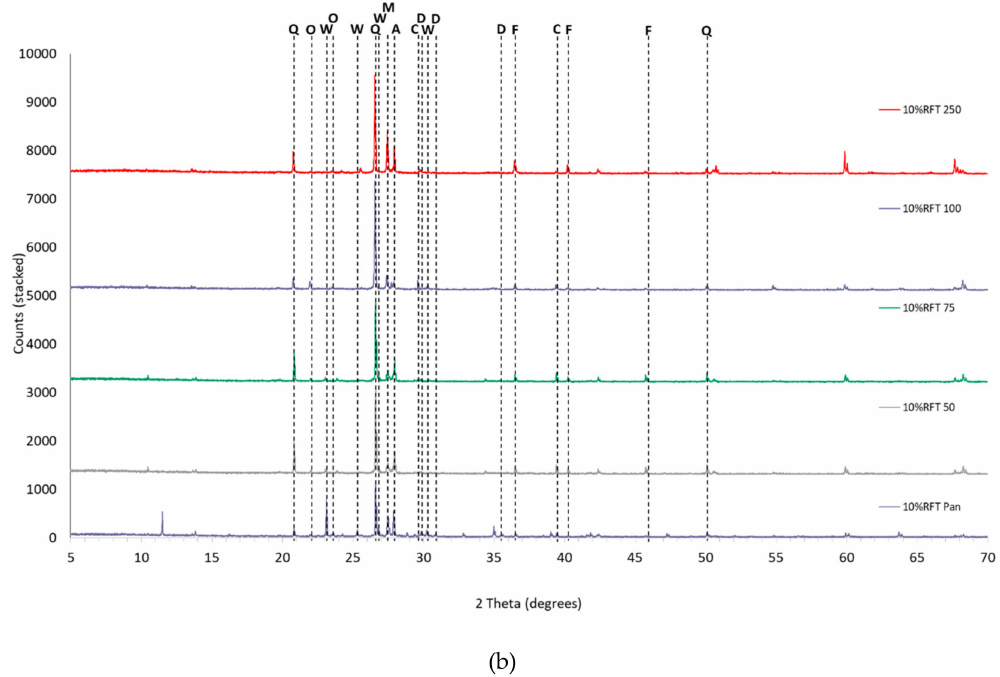
Figure 3. XRD di ff ractograms of: ( a ) control soil fractions, and ( b ) 10 wt.% rooftop soil fractions. Size fraction order of di ff ractograms, from top to bottom: 250 µ m, 100 µ m, 75 µ m, 50 µ m, and pan. Lettering relates to the main peaks of major mineral phases: albite (A), calcite (C), diopside (D), ferrihydrite (F), microcline (M), orthoclase (O), quartz (Q), and wollastonite